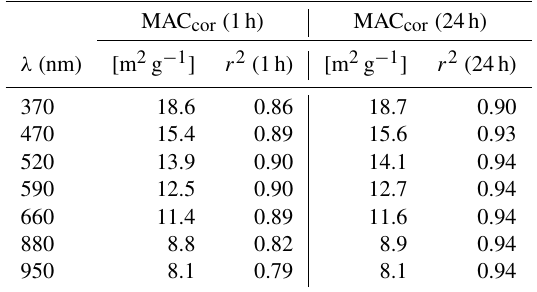
Table 4. MAC cor (Aethalometer; λ ) and r 2 values at Alert during